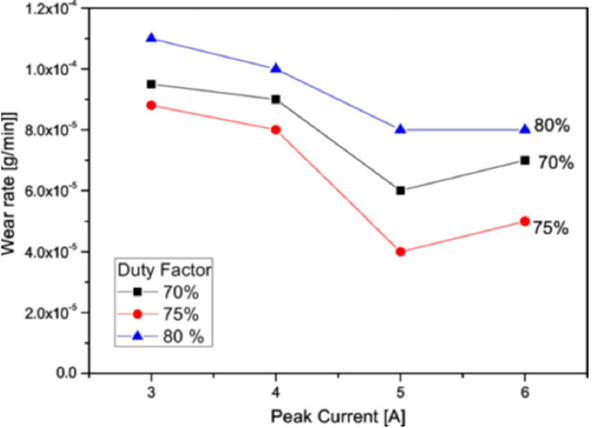
Figure 22. Change in wear rate with respect to the peak current and duty factor when the TiC-TiB 2 - coated Ti alloy experienced the ball-on-disc sliding wear test [85]. (With kind permission from Else- vier).